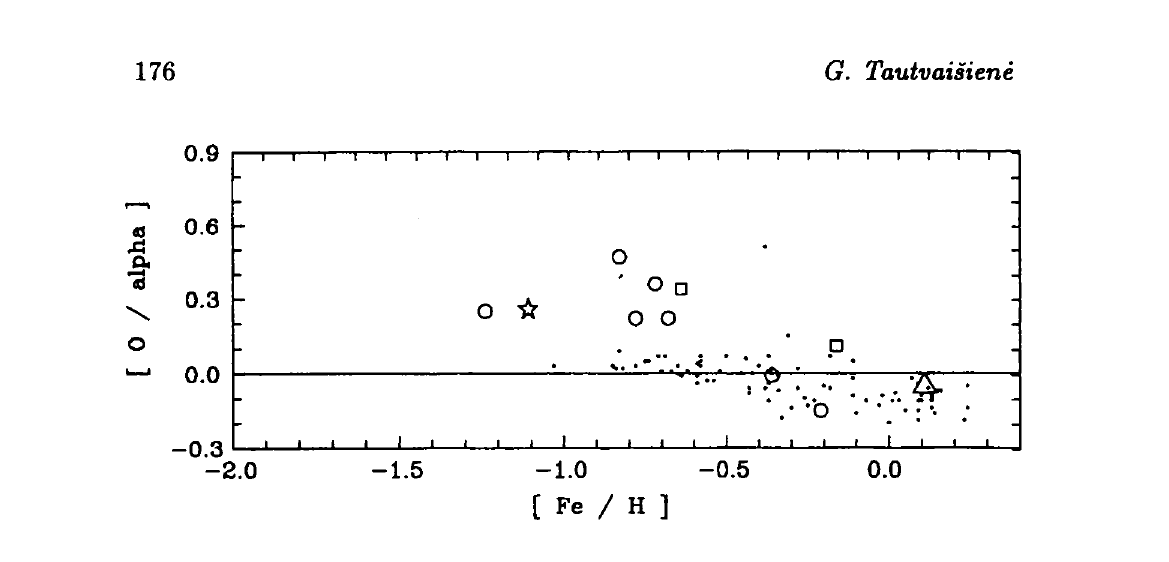
Fig. 7. Abundance ratios of oxygen and α-process elements versus the iron abundance. Symbols are the same as described in Fig.